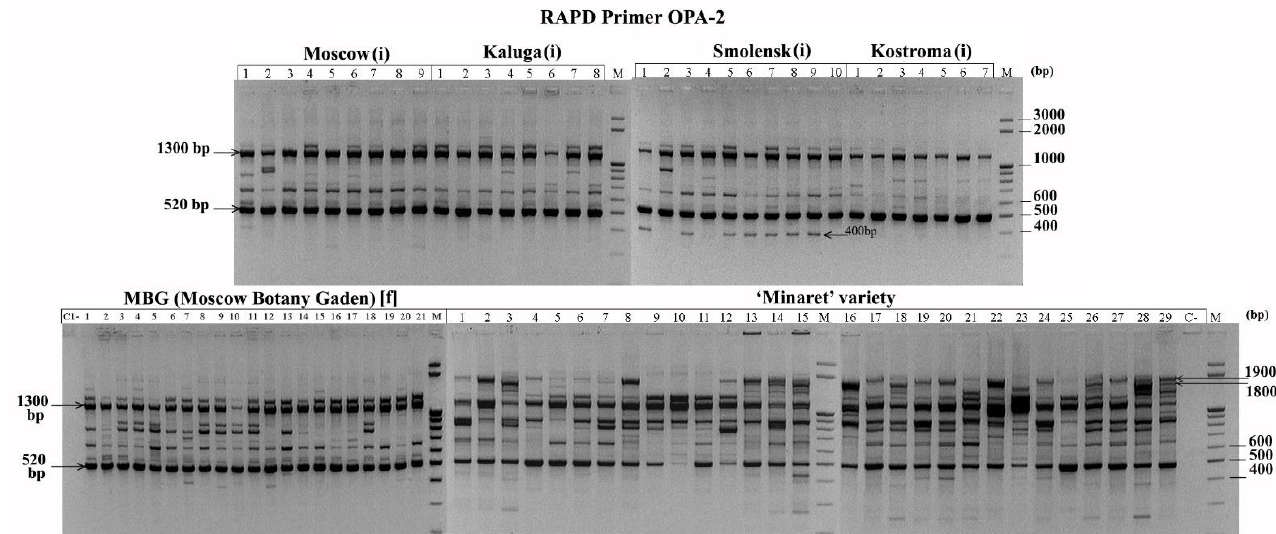
Figure 1. RAPD profile with the OPA-2 primer for L. polyphyllus . (i)—invasive population, [f]—feral population.